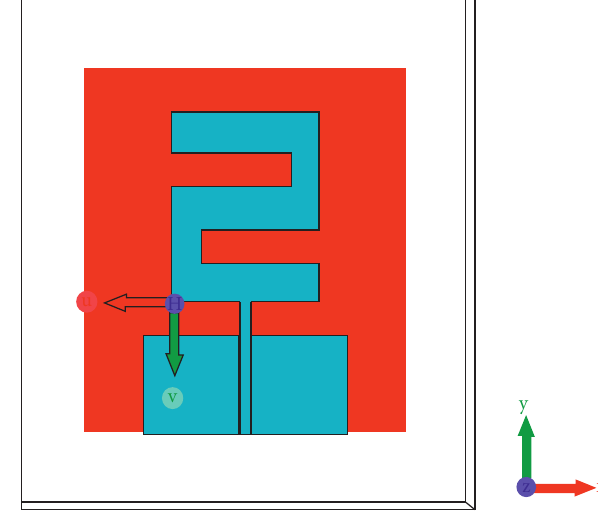
Figure 3: Z-shaped monopole element design using Antenna Design